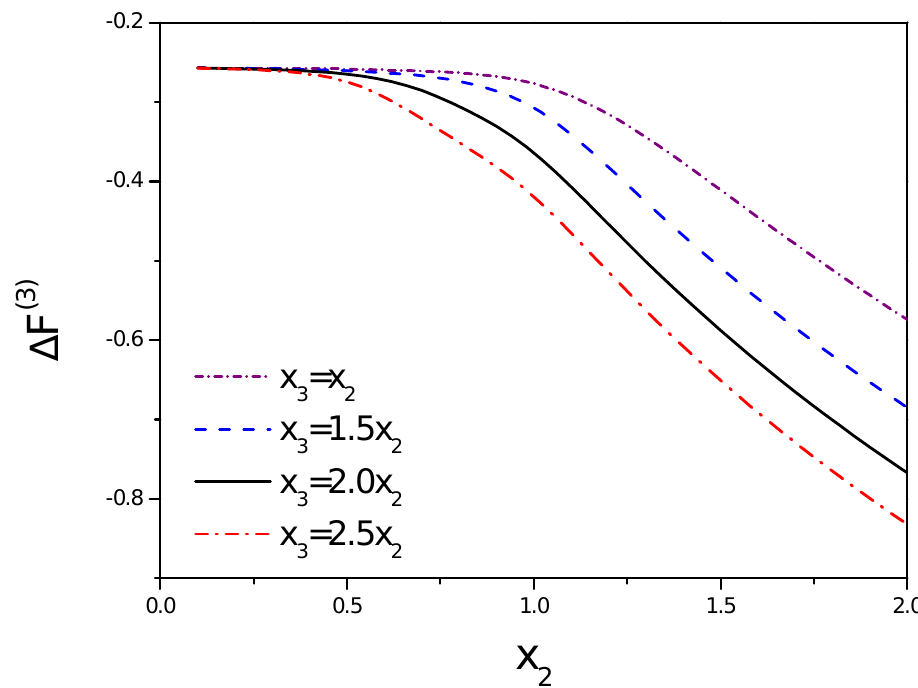
Figure 4. Variation of three molecules’ free energy as a function of the molecular interactions. x 2 denotes the interactions between molecule 1 and molecule 2. x 3 is the interaction between the third molecule and dimer. ∆ F ( 3 ) is defined as F ( 3 ) − 3 F ( 1 ) . The competition between molecules results in the variation of the free energy.